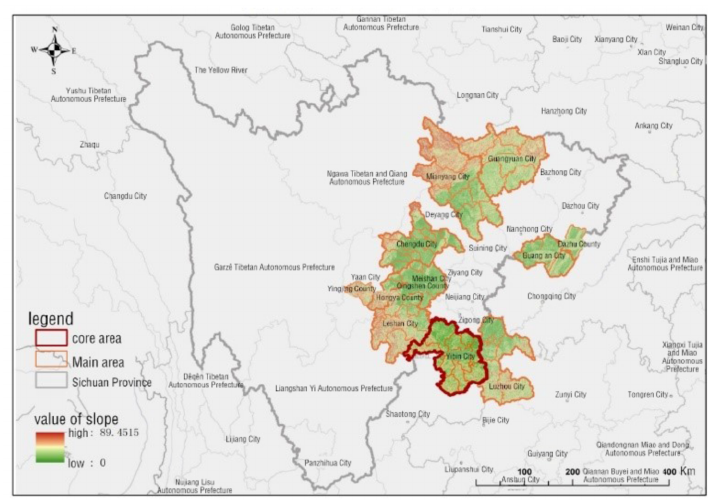
Figure 6. Slope analysis of the research areas in Sichuan Province.